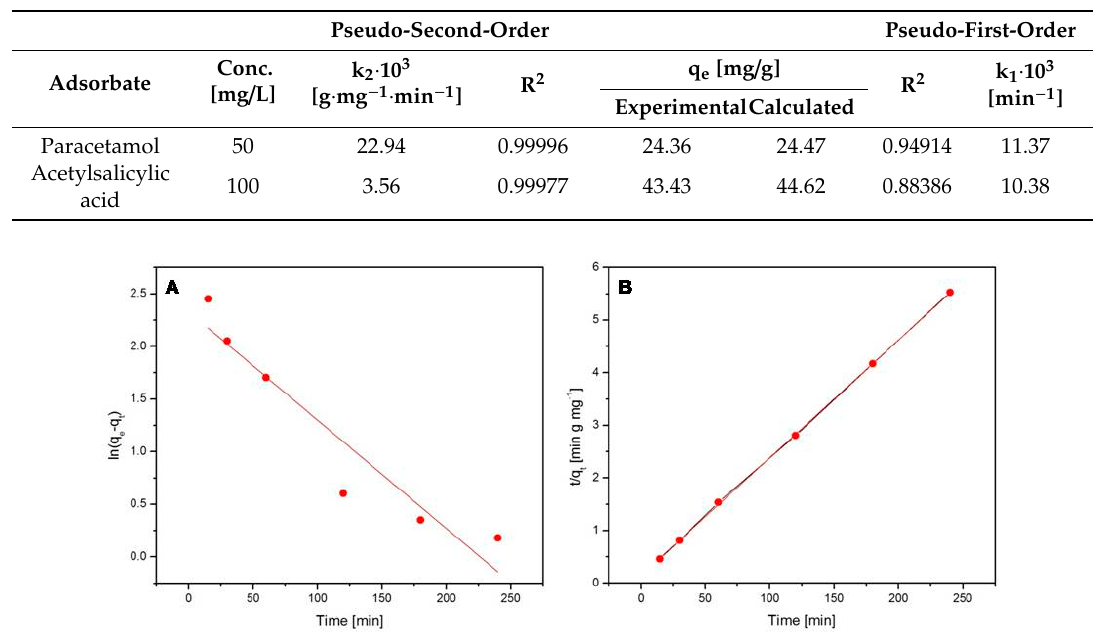
Figure 10. The pseudo-first-order ( A ) and the pseudo-second-order ( B ) models for acetylsalicylic acid adsorption.